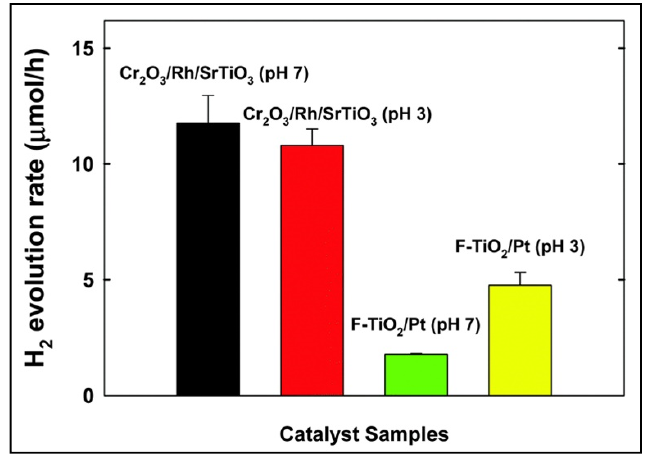
Figure 15. Comparison of the initial photocatalytic H 2 production rate between Cr 2 O 3 /Rh/SrTiO 3 and F-TiO 2 /Pt photocatalytic systems in the presence of 4-CP. Reprinted from reference [156]. Pub- lished by the Royal Society of Chemistry.